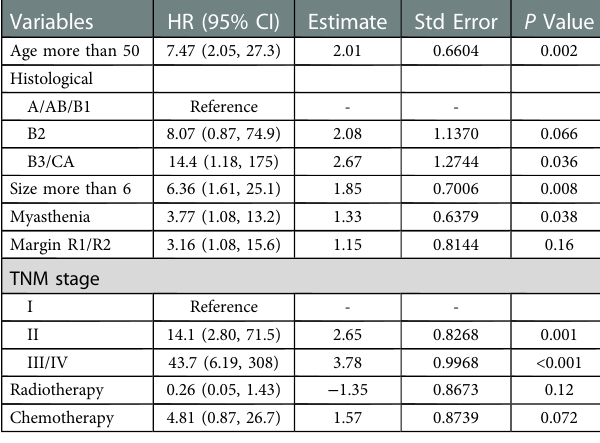
TABLE 3 Multivariate Cox regression model analyses of CSS in the nomogram